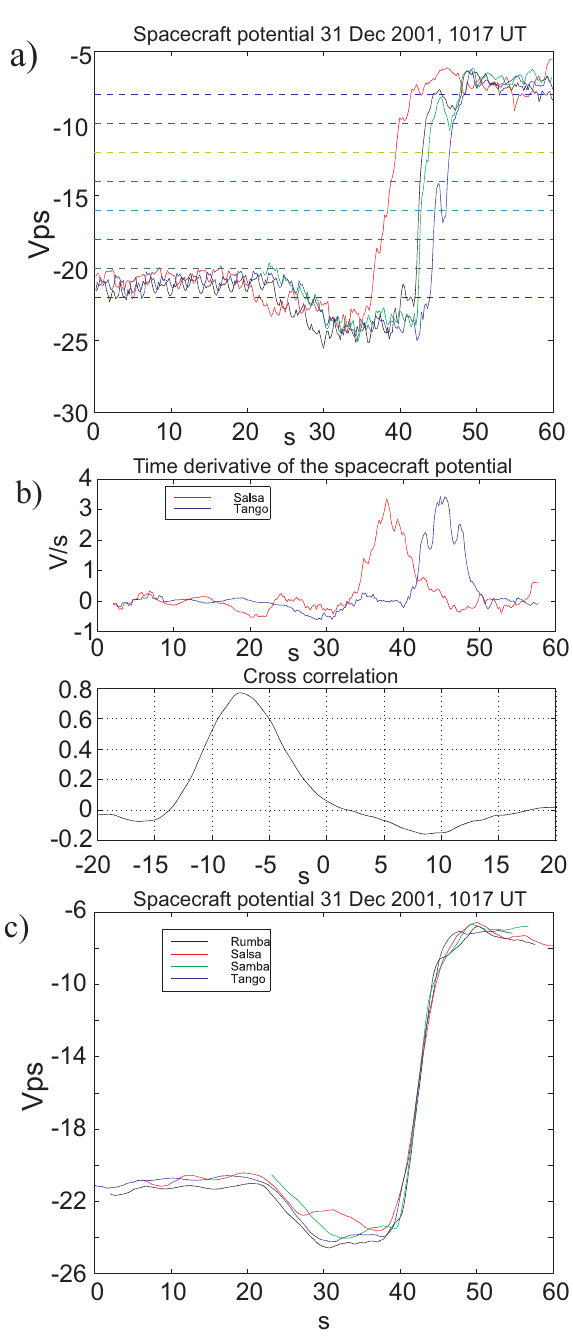
Fig. 4. (a) The parameter v ps for all four satellites, with a few specific potentials indicated, (b) the derivative of this potential for two satellites and the corresponding cross-correlation, (c) the low pass filtered potentials shifted in time to overlap. In this lower panel 10 s correspond to about 1000